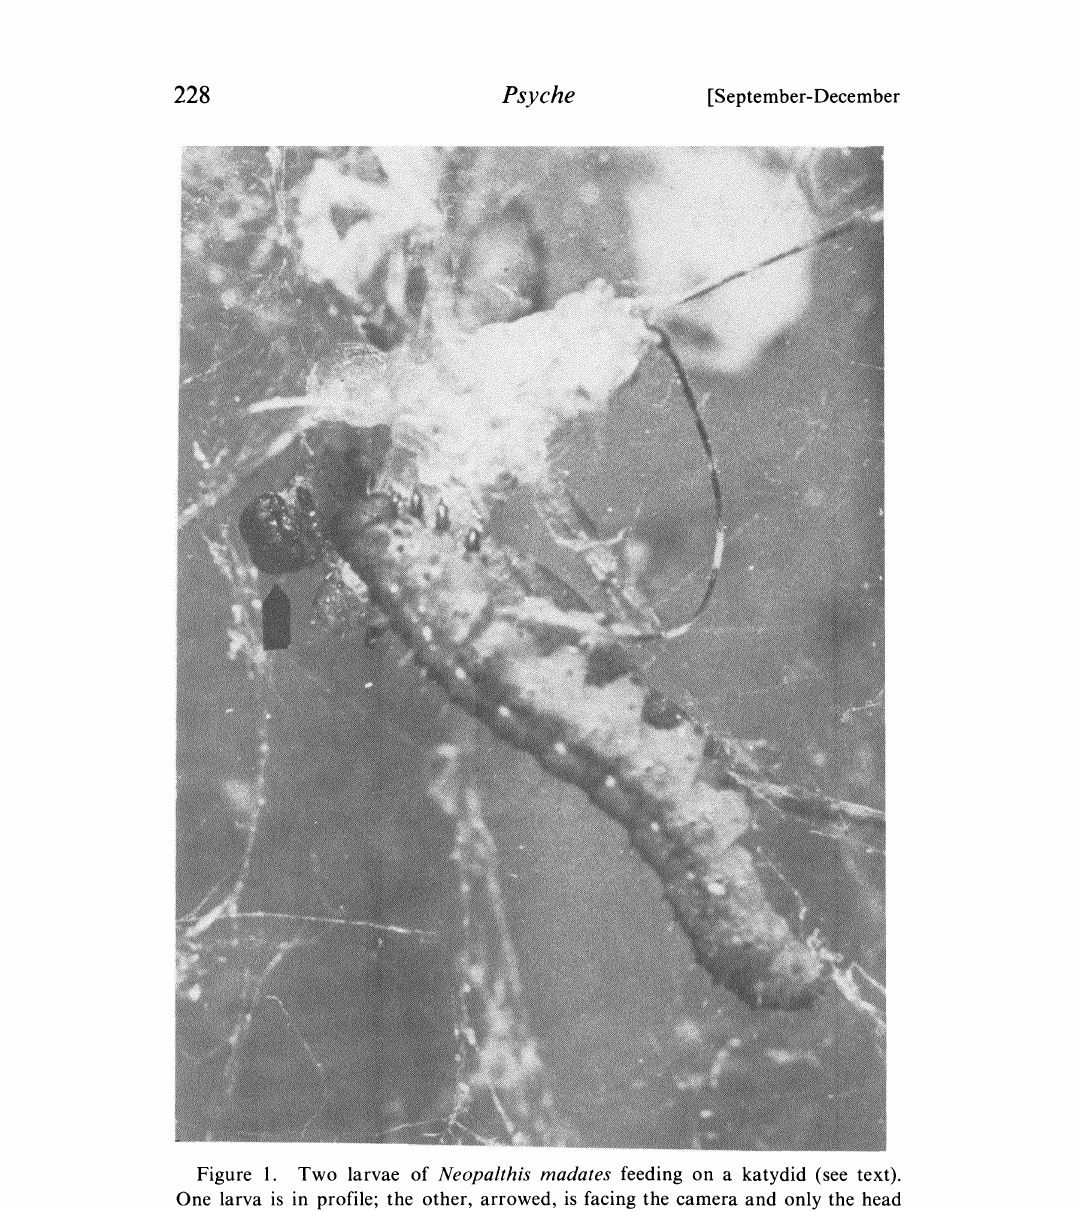
Figure 1. Two larvae of Neopalthis madates feeding on a katydid (see text). One larva is in profile; the other, arrowed, is facing the camera and only the head is